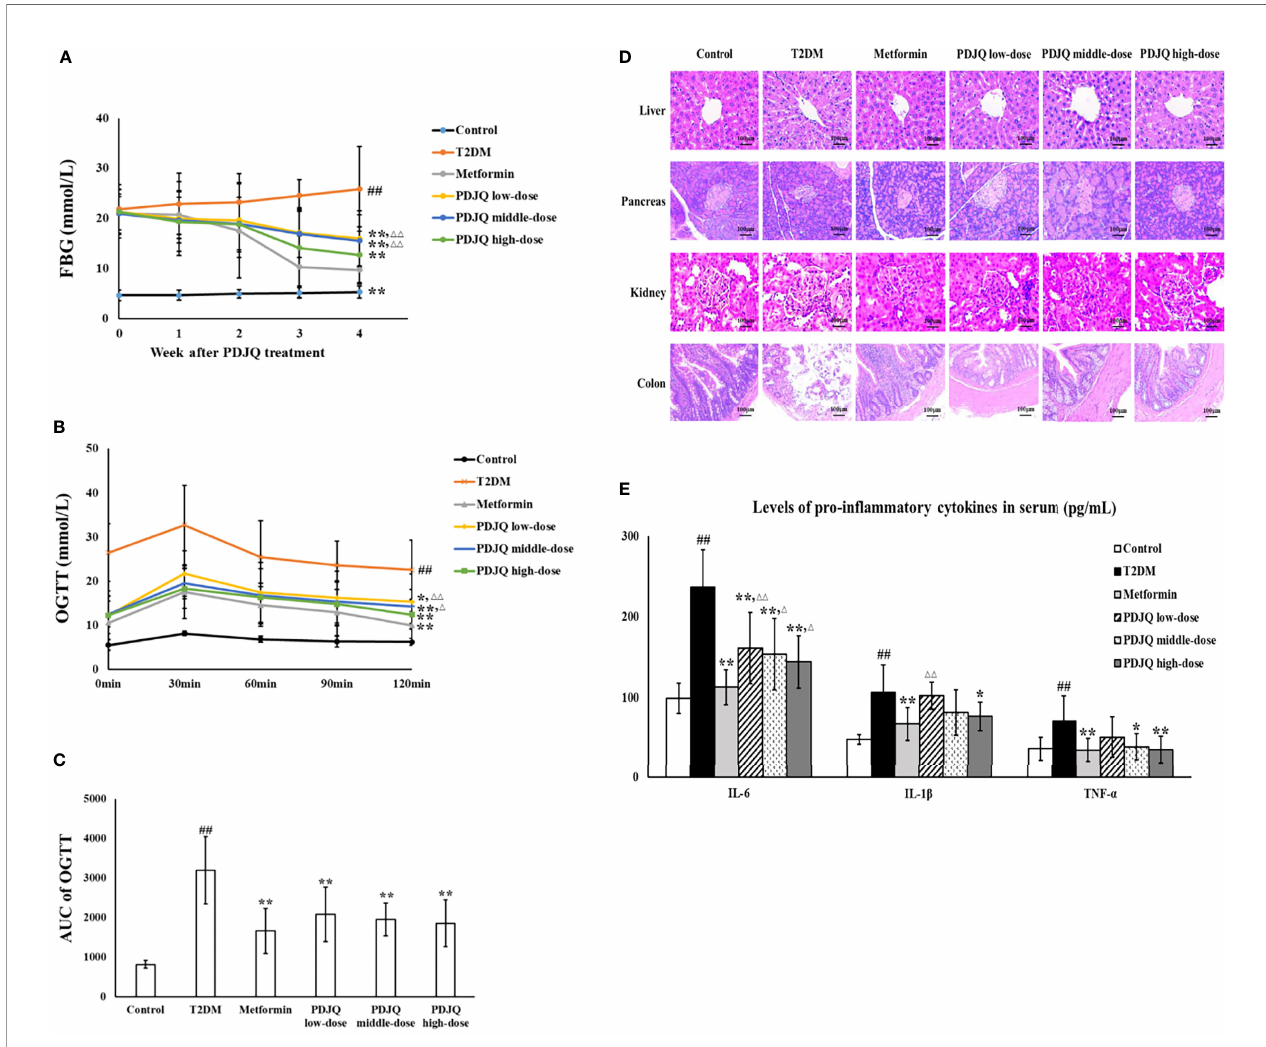
FIGURE 2 | PDJQ treatment alleviated the hyperglycemia, IR, pathological changes and in fl ammatory response in T2DM rats. (A) PDJQ treatment decreased the FBG in T2DM rats. (B, C) The AUC of OGTT was decreased in T2DM rats after metformin and PDJQ treatment. (D) PDJQ treatment signi fi cantly improved the pathological changes of liver, pancreas, kidney, and colon in T2DM rats (200×). (E) PDJQ treatment decreased the levels of pro-in fl ammatory cytokines in serum. Control, T2DM, Metformin, PDJQ low-dose, PDJQ middle-dose and PDJQ high-dose (n = 10 per group) groups. Data are presented as the mean ± SD. ## p < 0.01 as compared to the control group; ** p < 0.01 as compared to the T2DM group; △ p < 0.05 as compared to the Metformin group; △△ p < 0.01 as compared to the Metformin group.